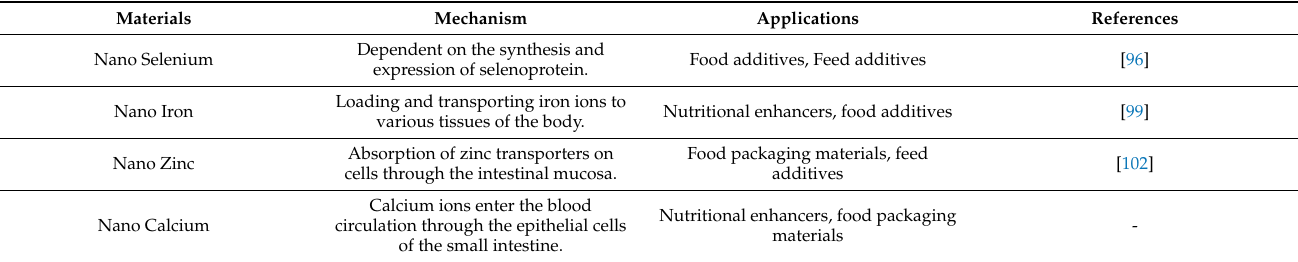
Table 4. Mechanism and application of nano-nutrient